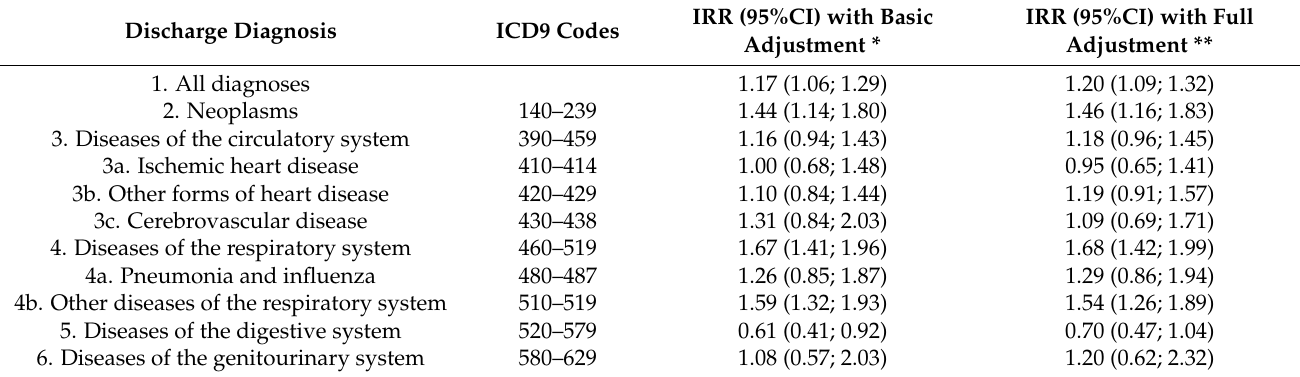
Table 4. Incidence rate ratios (IRRs) with 95% CIs for the association between admission during organizational Model 2 (vs. Model 1) and mortality by discharge